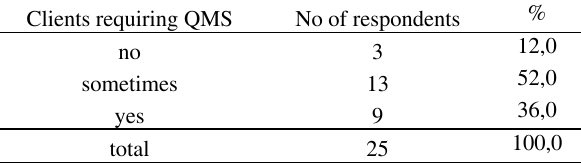
Table 3 . Attitude of clients towards quality management sys- tems in contracting companies